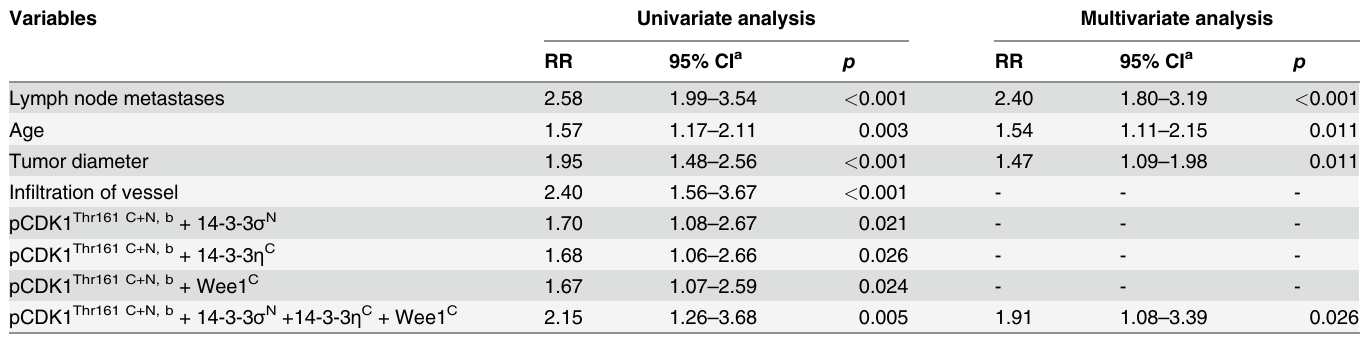
Table 2. Relative risk (RR) of dying from vulvar cancer (288 VSCC without neoadjuvant treatment cases).